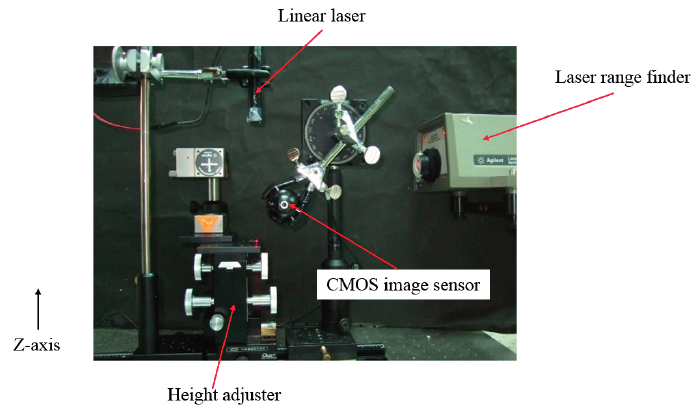
Figure 12. Use of a laser range finder to synchronize the height adjuster.